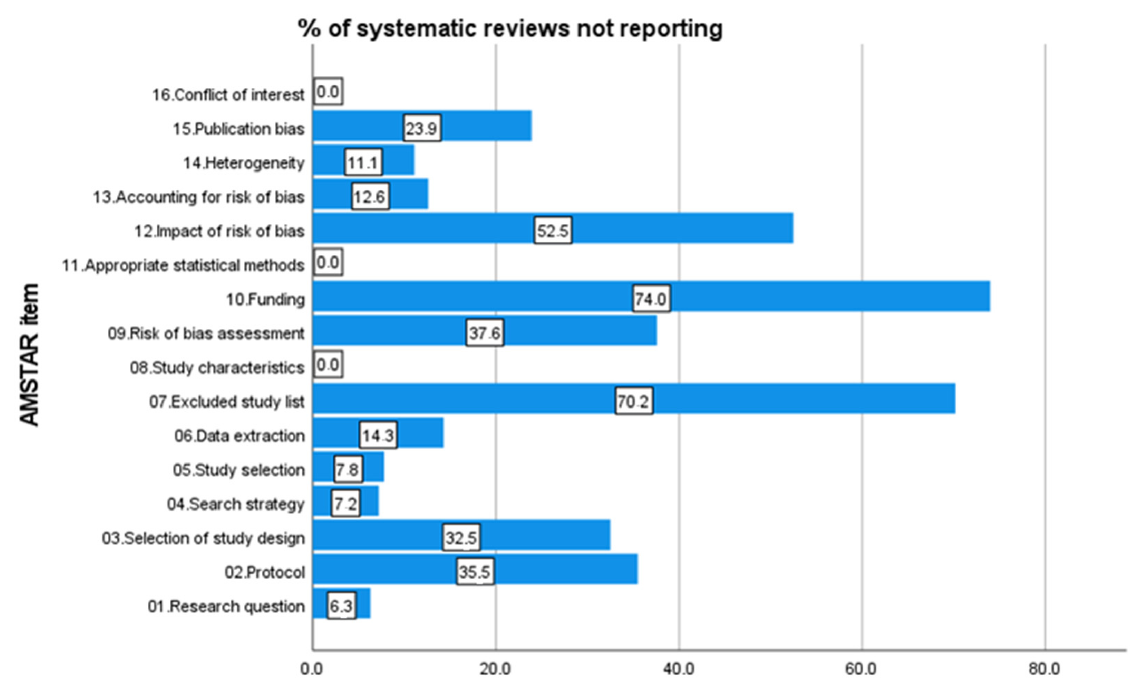
Figure 3. Bar chart of the percentages of systematic reviews not reporting the 16 items of the AMSTAR-2.